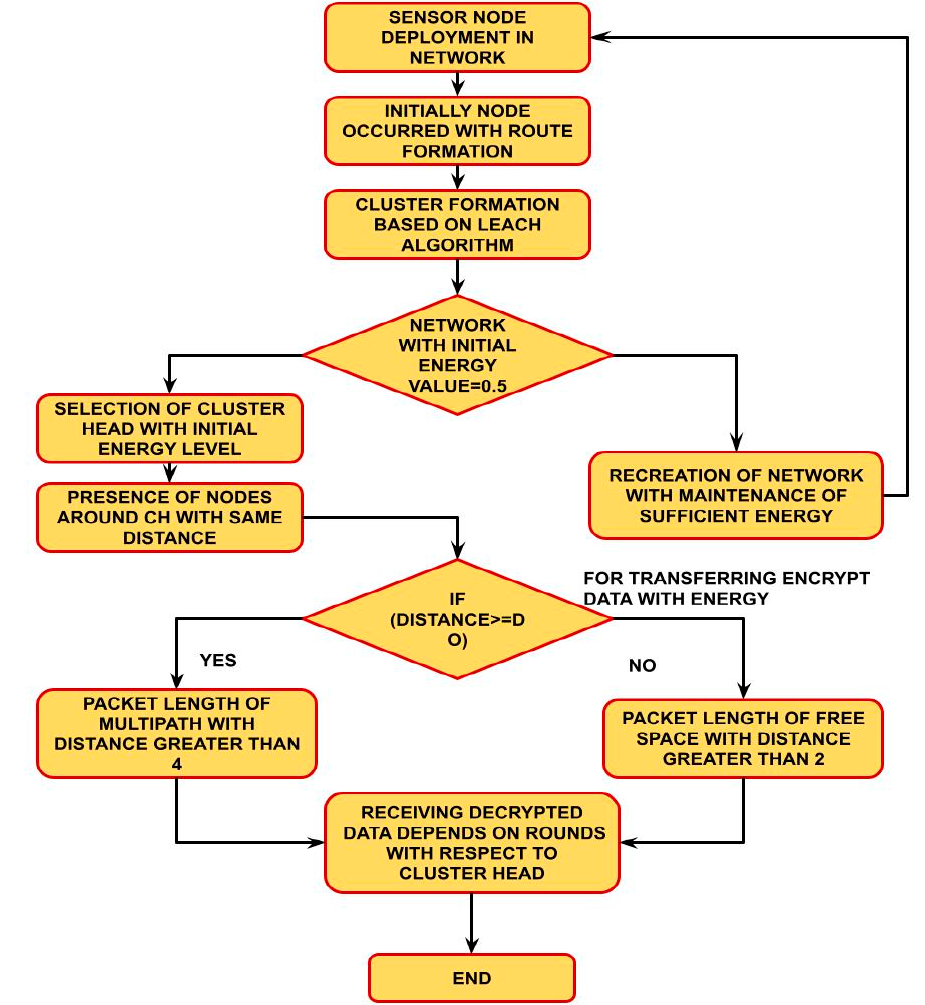
Figure 3. Transfer of encrypted data and receiver of decrypted data with energy consumption. Additionally, CDMA minimizes the interference between the clusters. Initially, 0.5 is the energy level where the network formation begins. The encrypted data transmission is based on distance between nodes, and rounds of CH determine the reception of decrypted data is shown in Algorithm